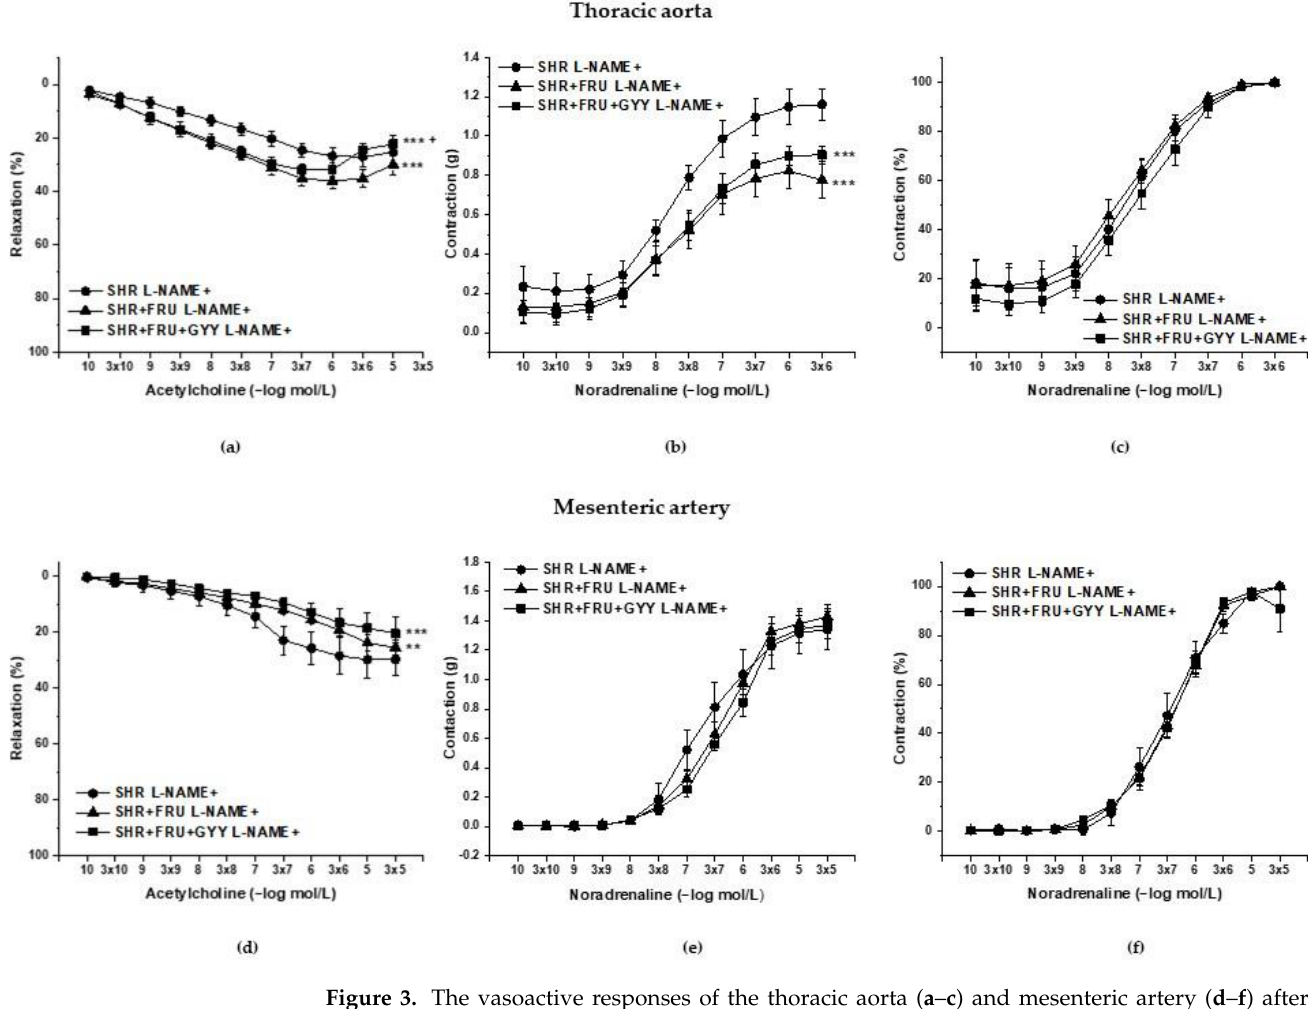
Figure 3. The vasoactive responses of the thoracic aorta ( a – c ) and mesenteric artery ( d – f ) after incubation with N G -nitro-L-arginine methylester (L-NAME). Endothelium-dependent vasorelaxant response of the thoracic aorta ( a ) and mesenteric artery ( d ). Noradrenaline-induced contractile response of the thoracic aorta ( b )-absolute response, ( c )-percent values of the maximum response), mesenteric artery ( e ) absolute response, ( f ) percent values of the maximum response). Arteries were isolated from spontaneously hypertensive rats (SHR), SHRs treated with fructose (SHR+FRU) and SHRs treated with fructose and GYY-4137 (SHR+FRU+GYY). The results are presented as the mean ± S.E.M. Statistical analysis was performed by two-way ANOVA with a Bonferroni post-hoc test. ** p < 0.01 and *** p < 0.001 vs. SHR, + p < 0.05 vs. SHR+FRU.